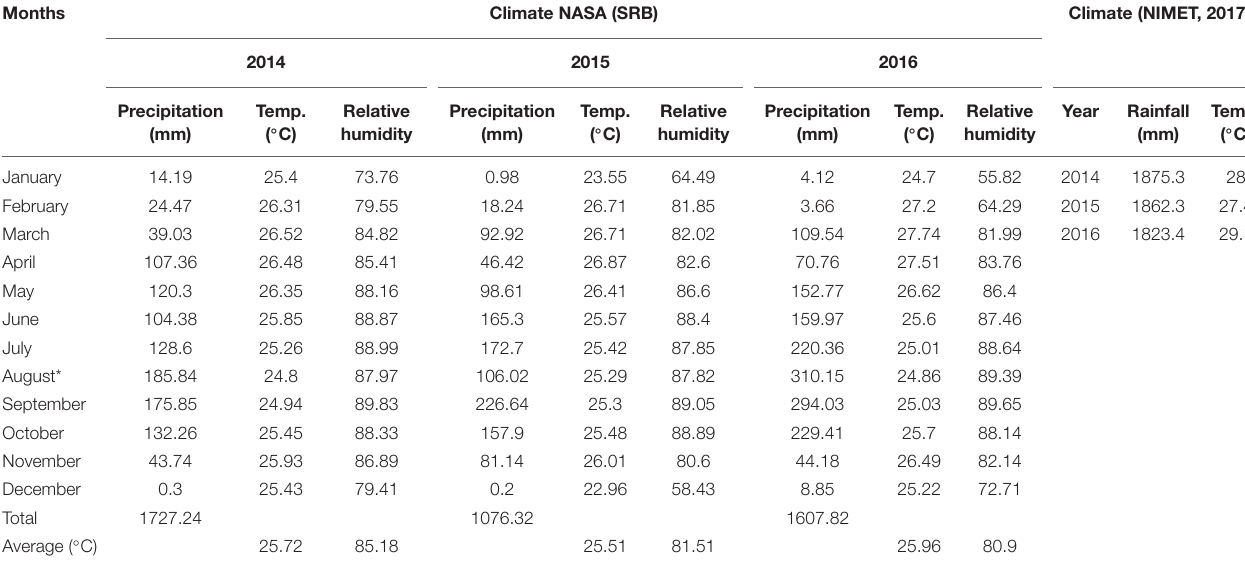
TABLE 1 | Climate data (NASA and NIMET) and onsite